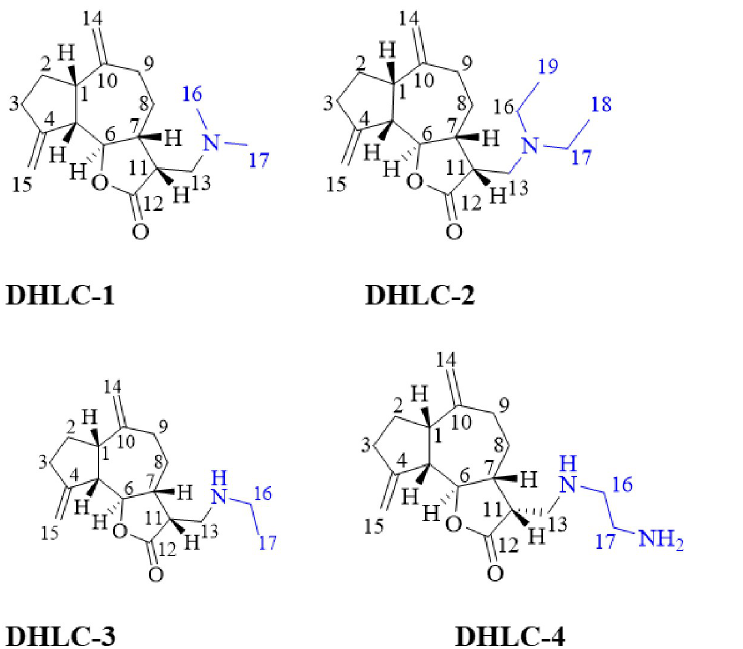
Fig 2. Structures of synthesized derivatives of dehydrocostus